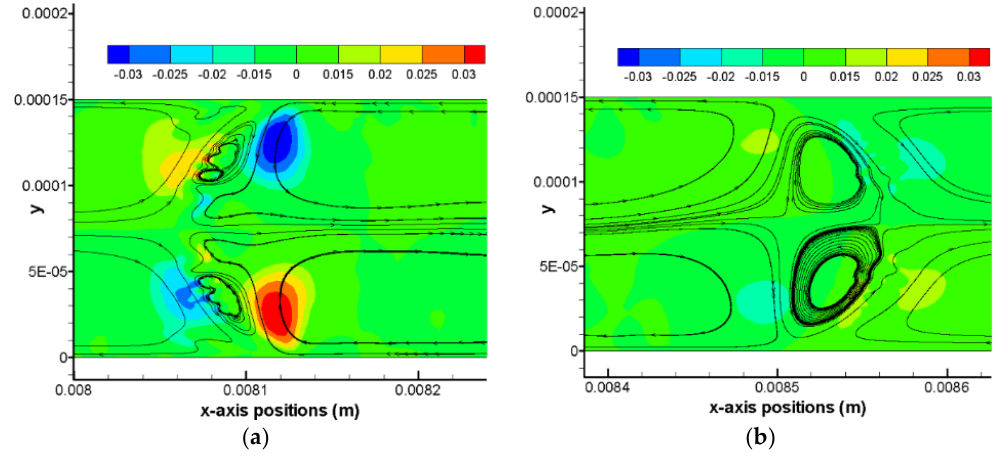
Figure 7. Contours of y -axis velocities and simple flow streamlines at ( a ) the back meniscus and ( b ) the front meniscus of the CO 2 drop at time moment t = 98.7 ms in Case 1. Color bands on the top show the magnitude of y -axis velocity, m/s.